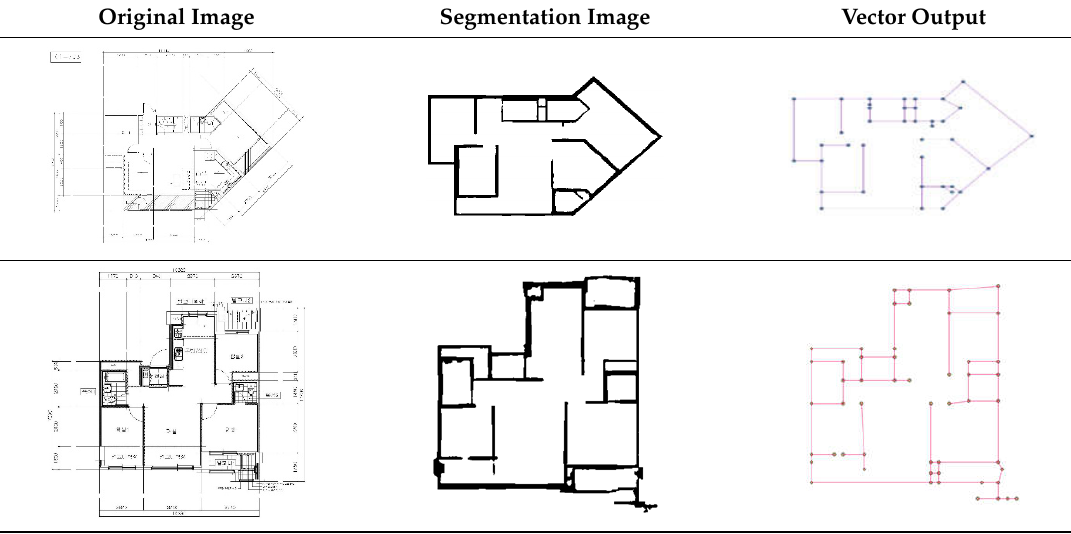
Table 8. Generated vector outputs with original and segmentation images.